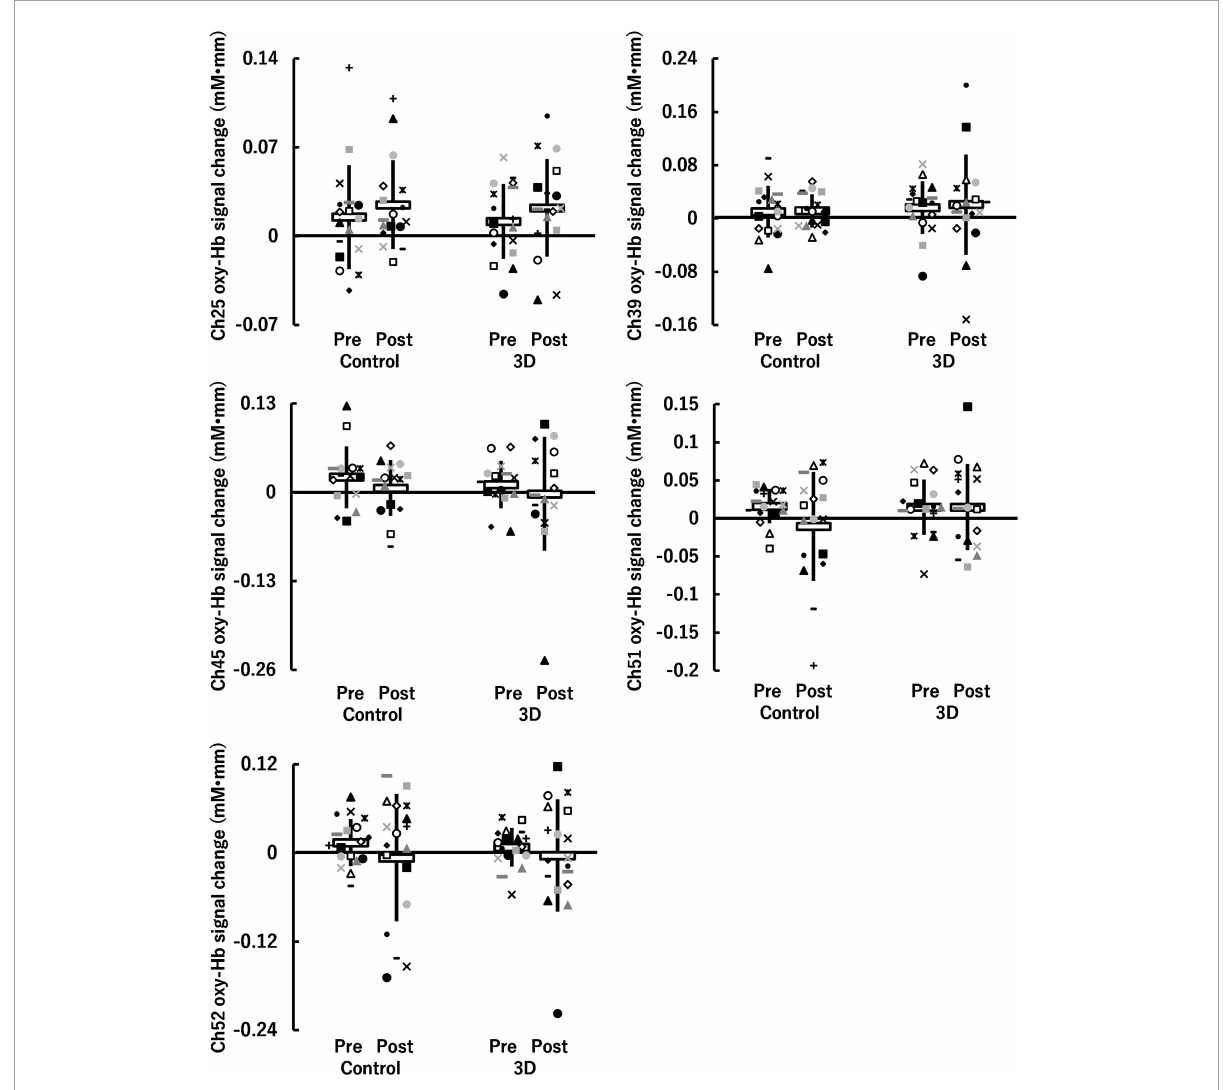
FIGURE7 Hemoglobin concentration changes (oxy-Hb signal changes) during Go/NoGo blocks in the auditory task before (Pre) and after (Post) watching a 1-h movie on television in 2D (Control) and 3D. Neither a time (Pre, Post) × condition (Control, 3D) interaction nor main effects of time and condition were significant ( P ≥ 0.05). White horizontal bars and thick solid lines in the vertical direction indicate means ± standard deviation, respectively. Each symbol indicates individual data (ch25: n = 17, ch39: n = 17, ch45: n = 15, ch51: n = 17, ch52: n =